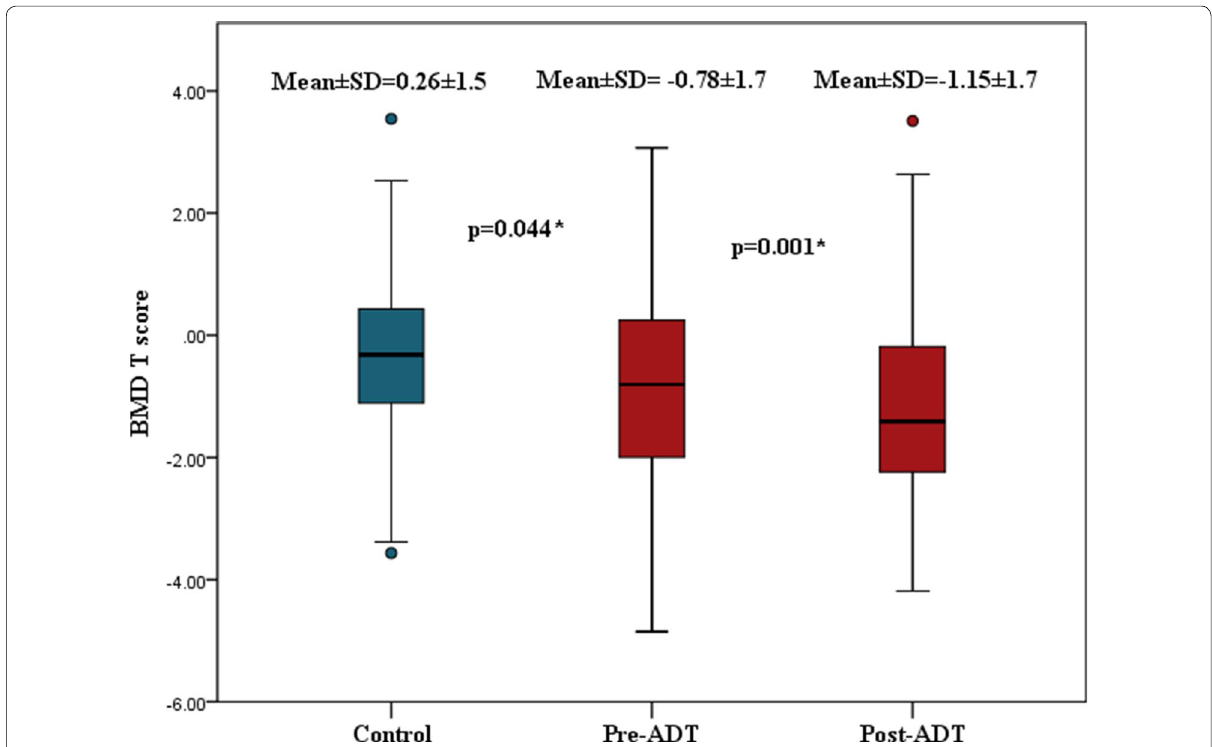
Fig. 1 Box plot comparing the mean BMD of the control and case group (pre- and